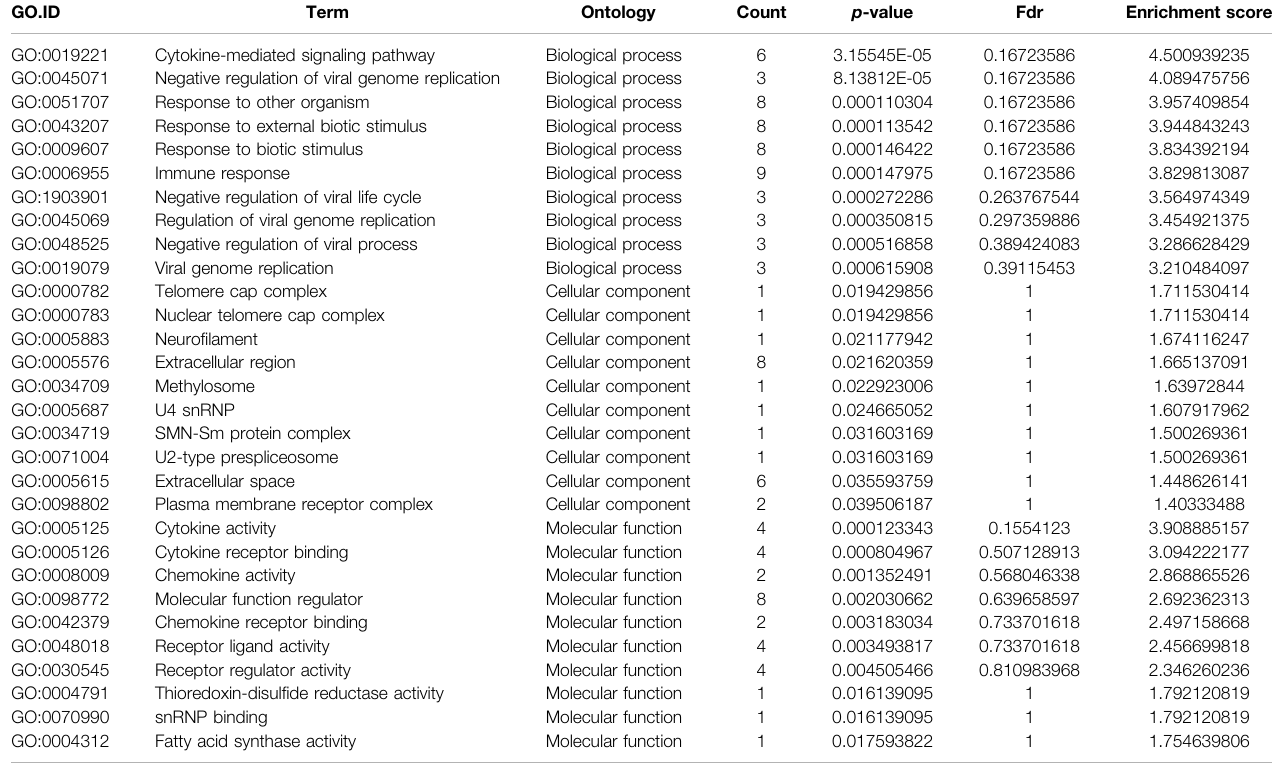
TABLE 4 | Gene Ontology analysis of the top ten hypo-methylated mRNAs. GO.ID